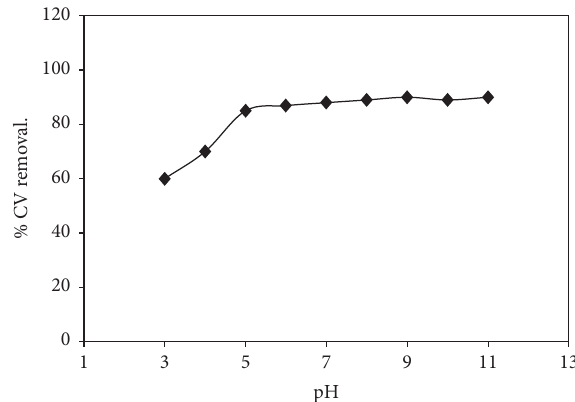
Figure 6: Result of starting pH solution on the removal of